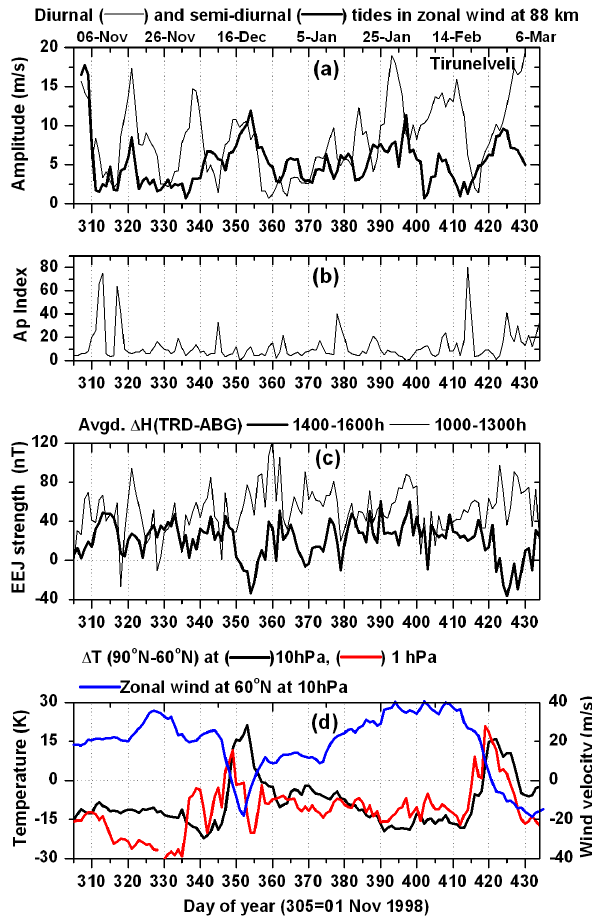
Fig. 1. (a) Daily variation of diurnal and semi-diurnal tidal ampli- tudes at 88km, (b) daily variation of A p index, (c) EEJ strength av- eraged for 10:00–13:00IST and 14:00–16:00IST, (d) Zonal mean temperature difference at 10hPa and 1hPa between the latitudes 90 ◦ N and 60 ◦ N and zonal mean zonal wind at 60 ◦ N at 10hPa for a time interval of 1–120 days starting from 1 November 2005.